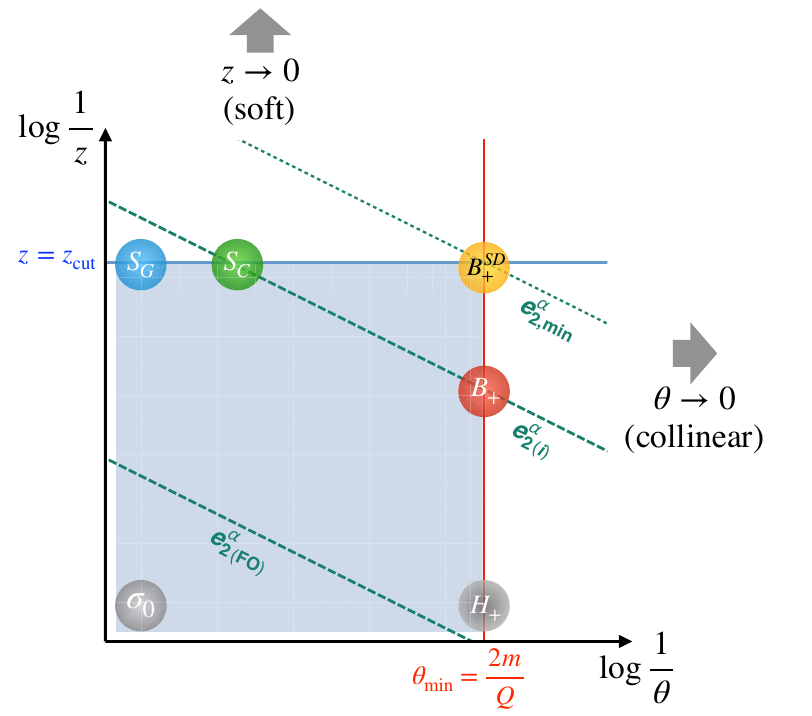
Figure 1 . Phase space in z, θ and associated modes in the singular limit. The allowed phase space , and the limit on the angle θ is determined by imposing the soft drop cut on the energy z cut < z = m/E . Lines of constant e ( α ) imposed by the jet radius, θ < R and the finite quark mass θ > θ min J 2 given by eq. (3.2) are shown at several values of e ( α ) . The light dotted line is the minimum value 2 in eq. (3.6). The first dashed line at e α represents a small value where the cross section is e ( α ) 2 , min 2( i ) represents a sensitive both to the quark mass and to grooming. The second dashed line at e α 2(FO) larger value where the cross section is not sensitive to quark mass or grooming and has to computed in fixed-order perturbation theory in full QCD (the exact shape of the phase space boundaries at larger z, θ will also have to be taken into account, see section 5). Note that this plot is made for the , the collinear-soft and ultracollinear case α = 1 < 1. (See figure 2 for the case α > 1.) At e ( α ) 2 , min 2 ). The relevant modes merge back into a single-scale, soft drop-sensitive ultracollinear mode ( B SD + , the hard function σ , and the matching coefficient H to regions for the global soft function S G 0 + bHQET are also